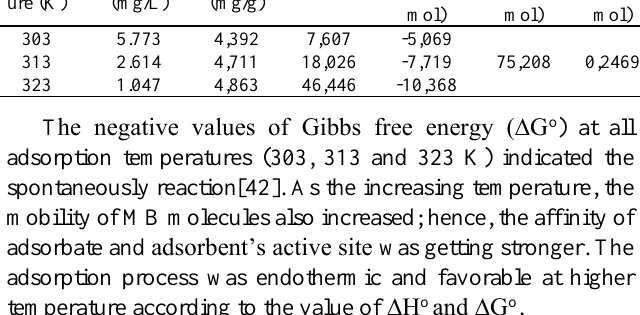
Table 5. Thermodynamic results on MB adsorption using SHC270 Temperat ure